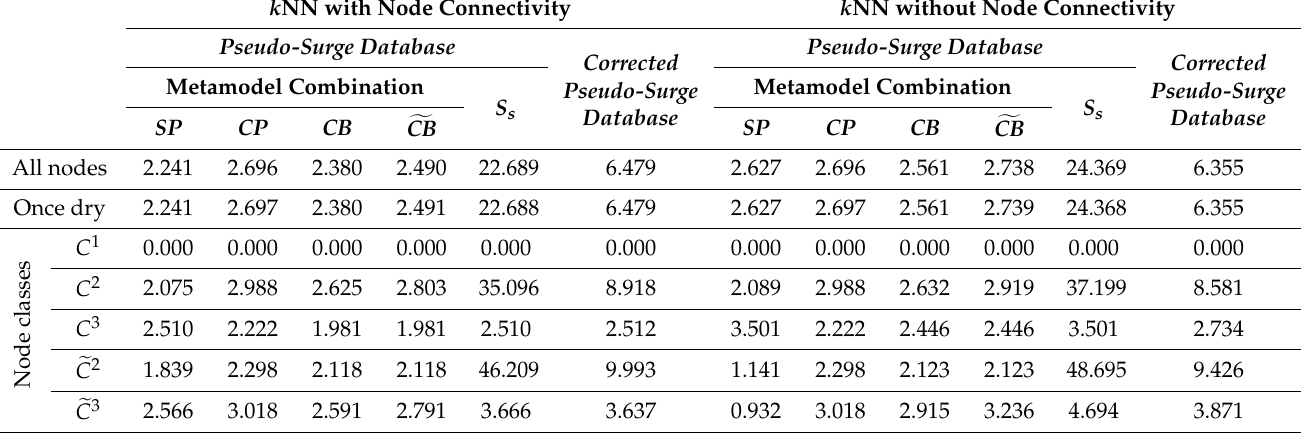
Table 9. False-positive misclassification ( + MC ) percentage for different variants and different groups of nodes for different surrogate model variants for the implementation that considers different surge metamodels for different classes of nodes.